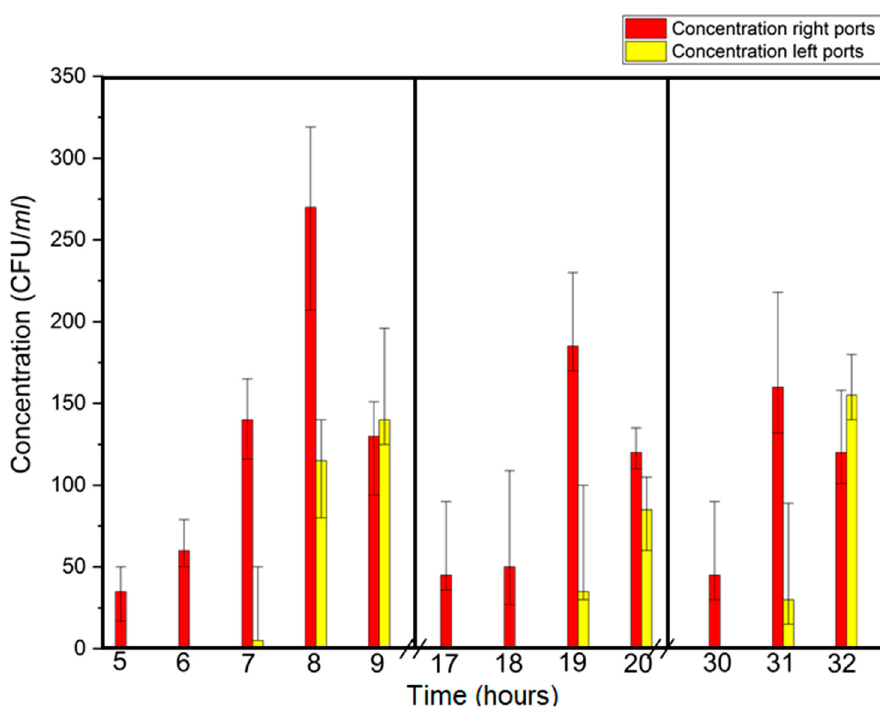
Figure 2. Breakthrough time ( ± 1 h) and concentration of E . coli as a function of time in three time periods.